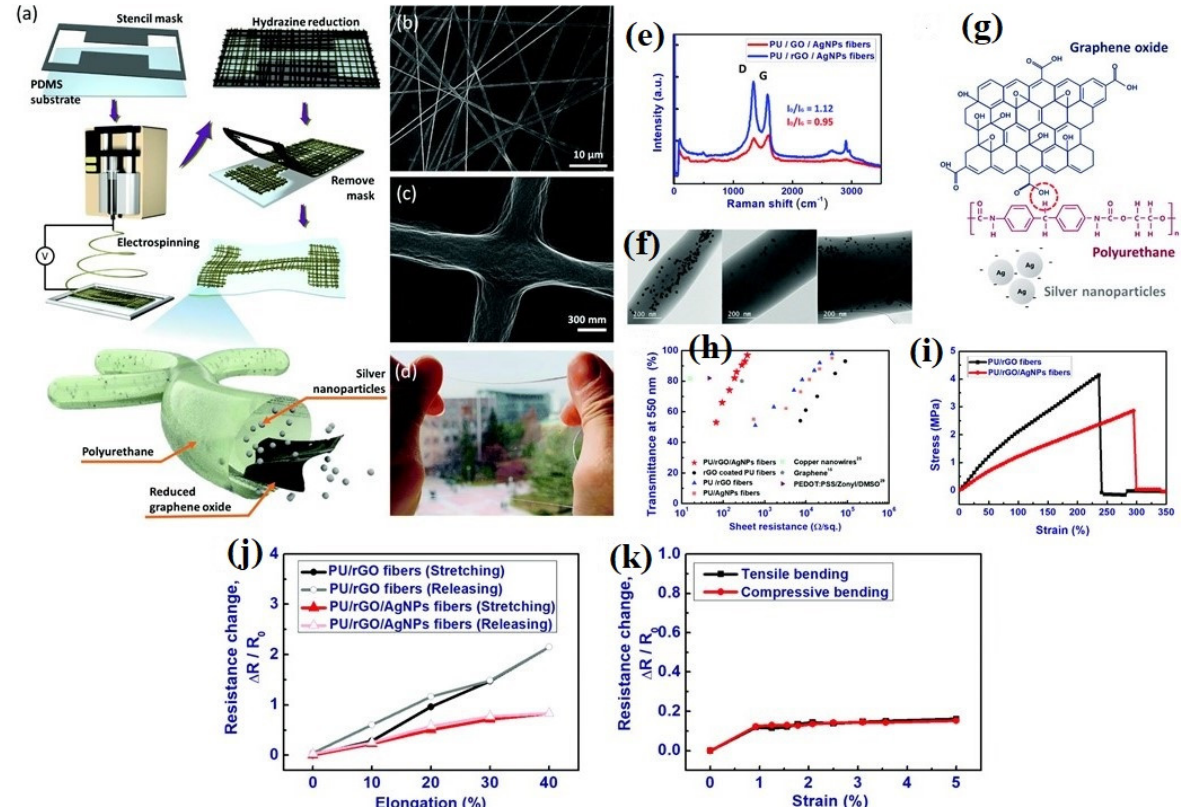
Figure 4. ( a ) Technological flow chart of the patterned STNNE. ( b ) FESEM image of the networked NFs. ( c ) FESEM image of the intersections of the NFs. ( d ) Optical photographs of the stretchable and transparent networked NF film. Dispersion of PU/rGO/AgNPs in NFs. ( e ) Raman spectra of PU/GO/AgNP nanofiber and PU/rGO/AgNP nanofiber samples with a GO:AgNP loading ratio of 1:1.25. ( f ) TEM images of NFs with diameters of ~290, ~484, and~933 nm. ( g ) Schematics of the functional groups on GO, chemical structure of polyurethane, and negative surface charges of AgNPs. GO nanosheets can be hydrogen-bonded to the PU matrix by the functional moieties of the carboxyl and hydroxyl groups. ( h ) Optical transmittance sheet resistance of the networked NFs for different types of NFs: rGO-coated PU, PU/rGO, PU/AgNP, and PU/rGO/AgNP NFs with that of copper nanowires, PEDOT: PSS/Zonyl/DMSO, and graphene. ( i ) Stress–strain curves of PU/rGO and PU/rGO/AgNP NFs. Evaluation of STNNEs under stretching conditions. ( j ) Resistance change (ΔR/R0) versus elongation of the PU/rGO and PU/rGO/AgNP nanofiber electrodes on PDMS substrates. ( k ) Resistance change (ΔR/R0) versus low strain under tensile and compressive bending of STNNEs. Reproduced with permission from [104]. Copyright 2020 Springer Nature.